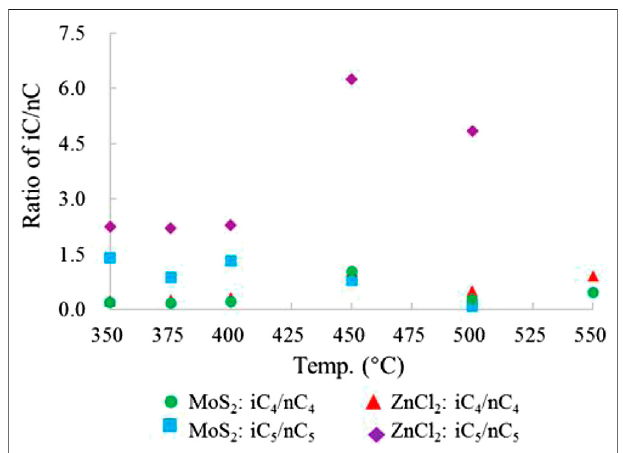
Frontiers in Earth Science |